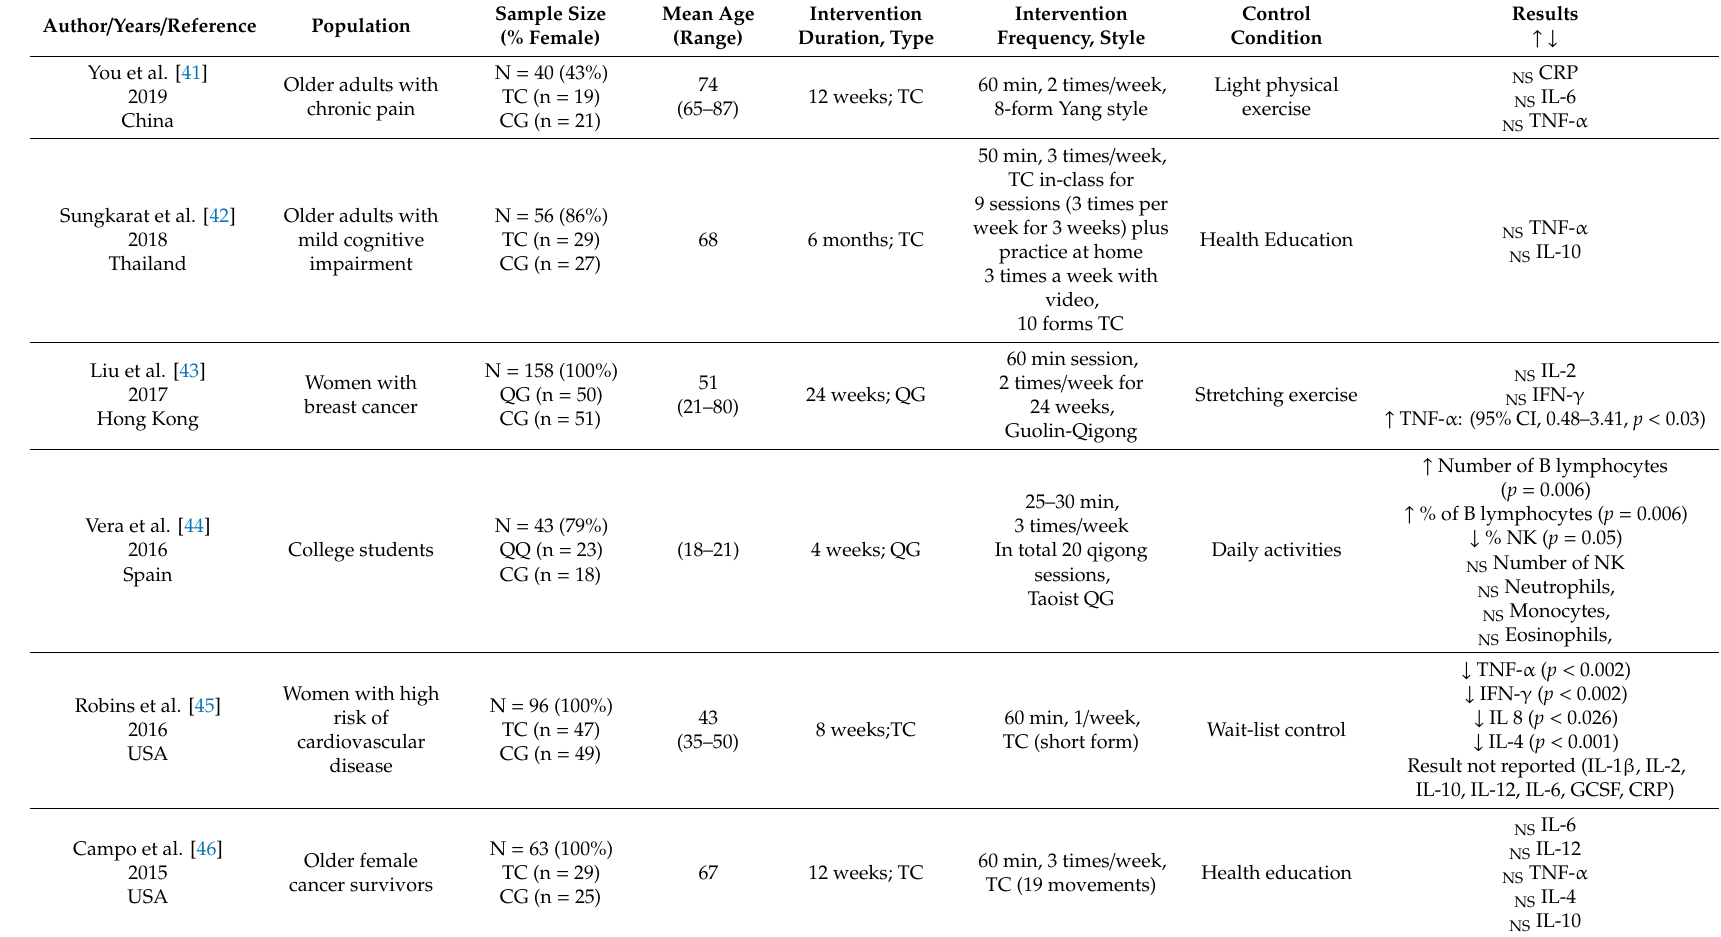
Table 1. Study characteristics of the 19 randomized clinical